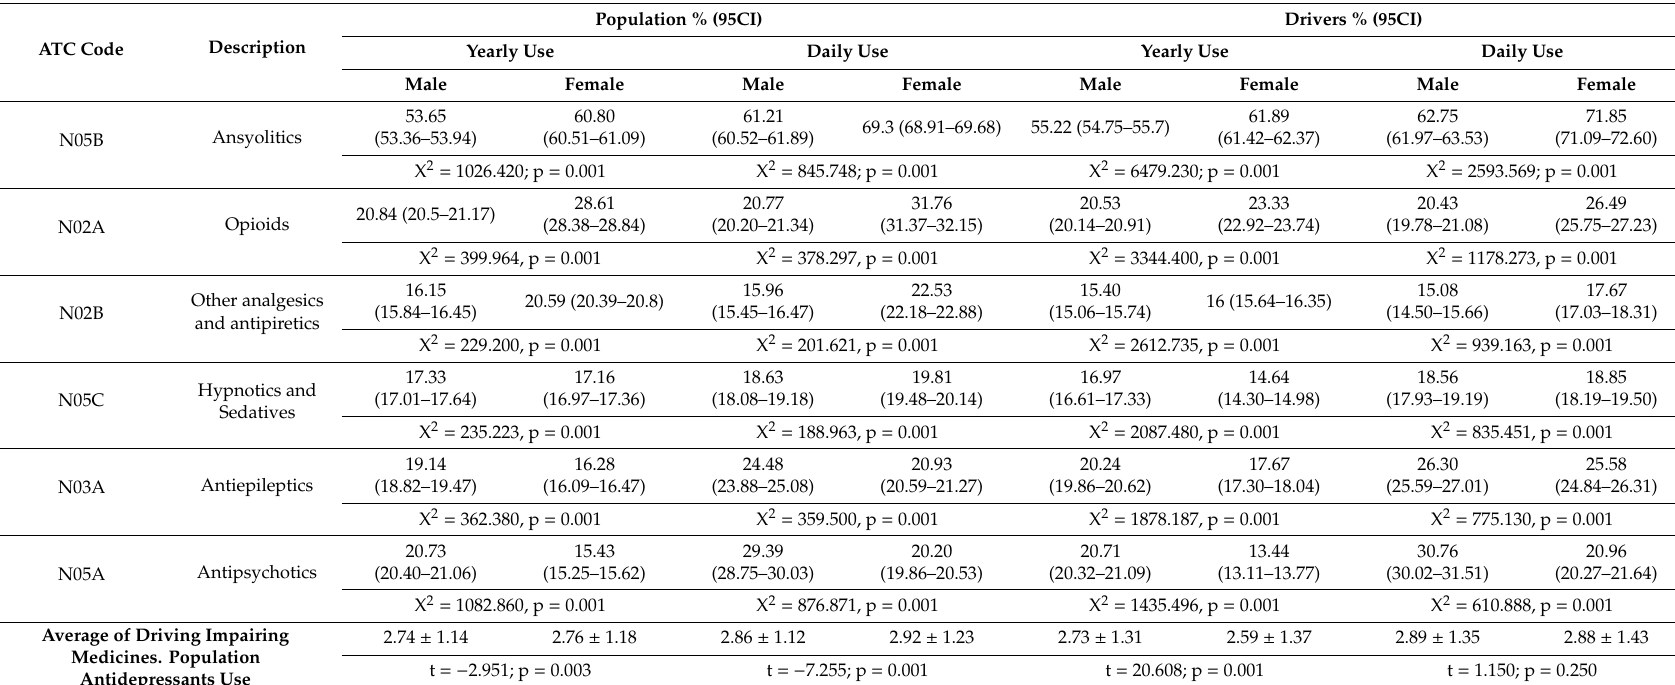
Table 2. Other driving-impairing medicines (DIMs) used concomitantly with